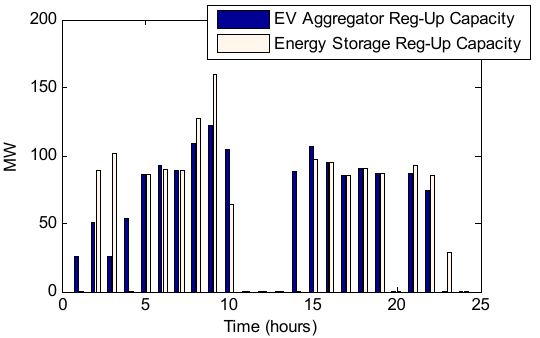
Figure 8. Regulation down capacity of the EV aggregator and dedicated storage unit.